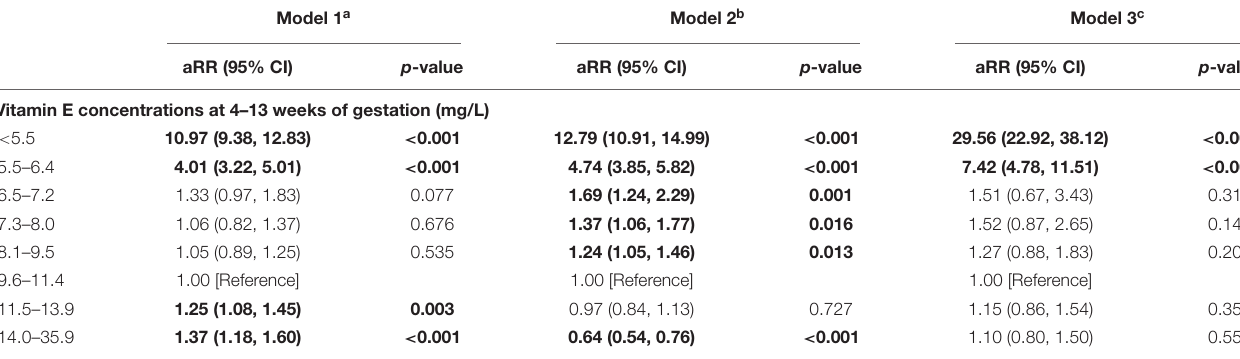
FIGURE 3 | Predicted absolute risks of pre-eclampsia with respect to gestational vitamin E status. Predicted absolute risks of pre-eclampsia with 95% CIs were calculated with respect to (A) the vitamin E concentrations in the first trimester and (B) the gestational change by performing logistic regression models with restricted cubic splines. Model A adjusted for the confounding of the concentrations in the first trimester and the gestational change on each other. Model B additionally adjusted for age, education, ethnic origin, region, Hukou, ART, primigravida, pre pregnancy BMI, and diabetes. (C) Predicted absolute risks of pre-eclampsia calculated by using Model B with respect to gestational vitamin E change given varied baseline concentrations (1st, 2.5th, 5th, 10th, 25th, 50th, 75th, 90th, 95th, 97.5th, and 99th percentiles) in the first trimester. TABLE 2 | Adjusted relative risks (95% CI) for pre-eclampsia according to vitamin E concentrations in the first trimester. Model 1